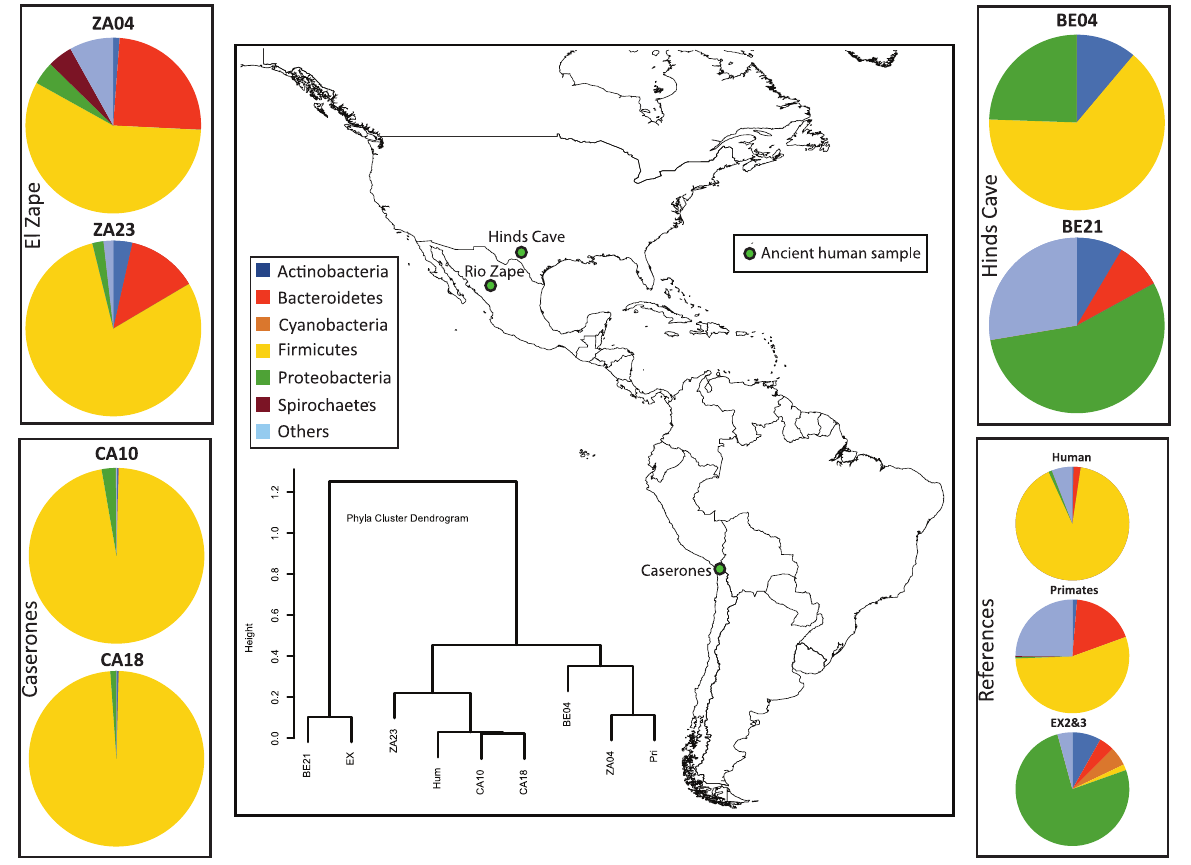
Figure 1. The geographic distribution and bacterial diversity of the included samples. These data resulted from comparison of the 16S rRNA V3. Taxon distribution and cluster dendrogram were limited to phyla with a frequency of 5% or more.